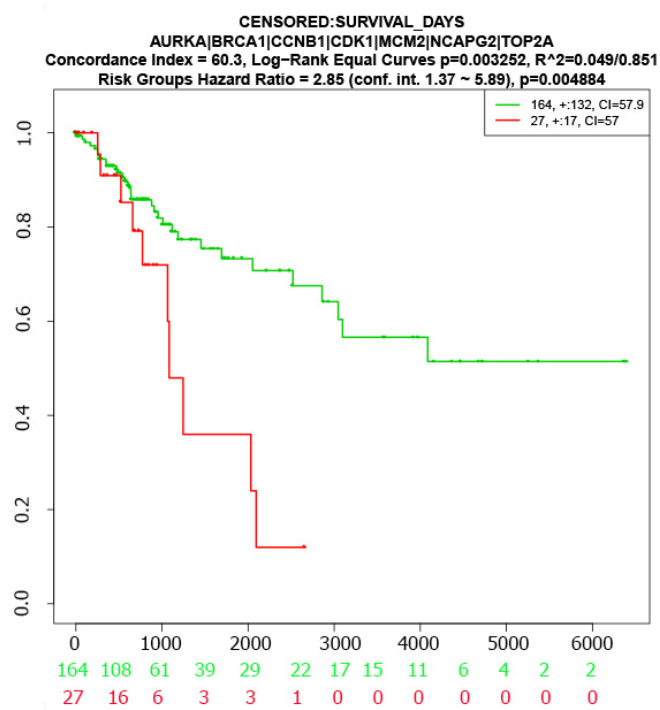
Figure 5. The multivariate survival curves of CC patients based on KGs.